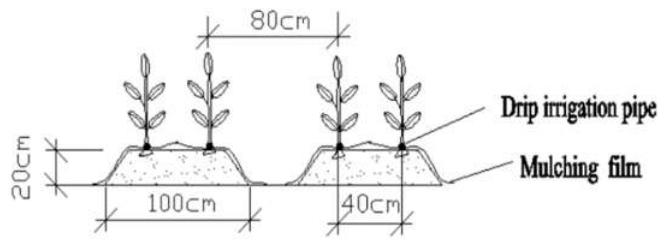
Figure 1. Layout of drip irrigation pipe, tomato-cropping pattern.